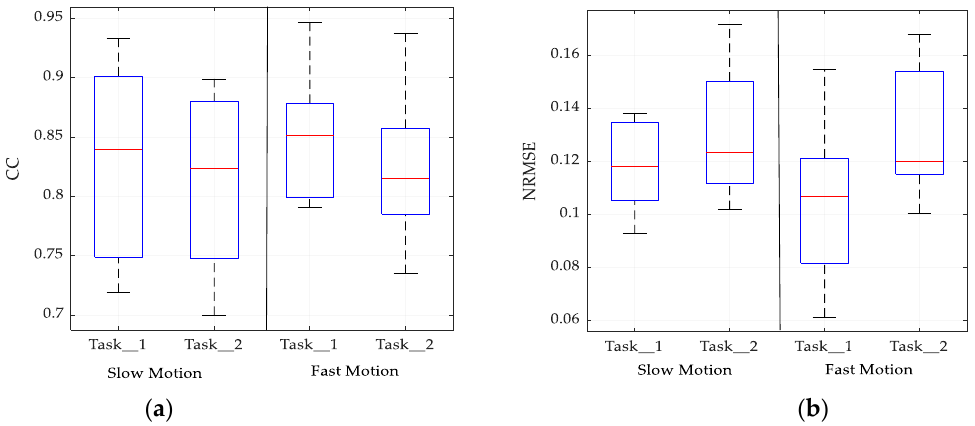
Figure 10. Prediction performance for tasks under consideration. ( a ) Performance in terms of CC index; ( b ) performance in terms of NRMSE index.